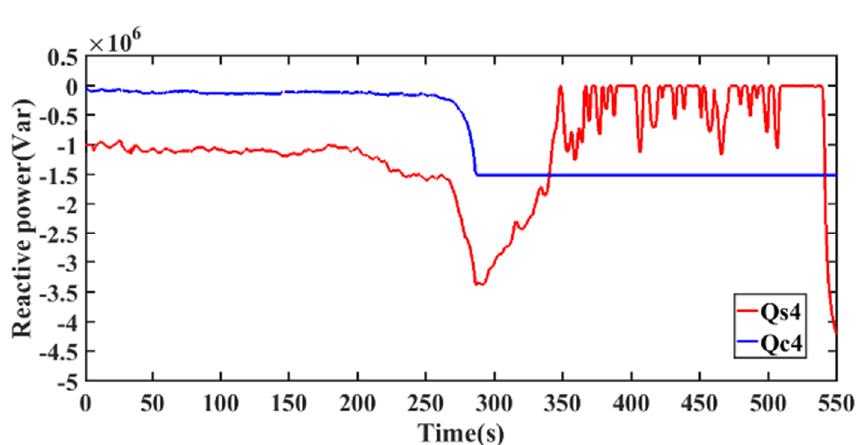
Figure 16. Stator reactive power output and converter reactive power output of WT4.